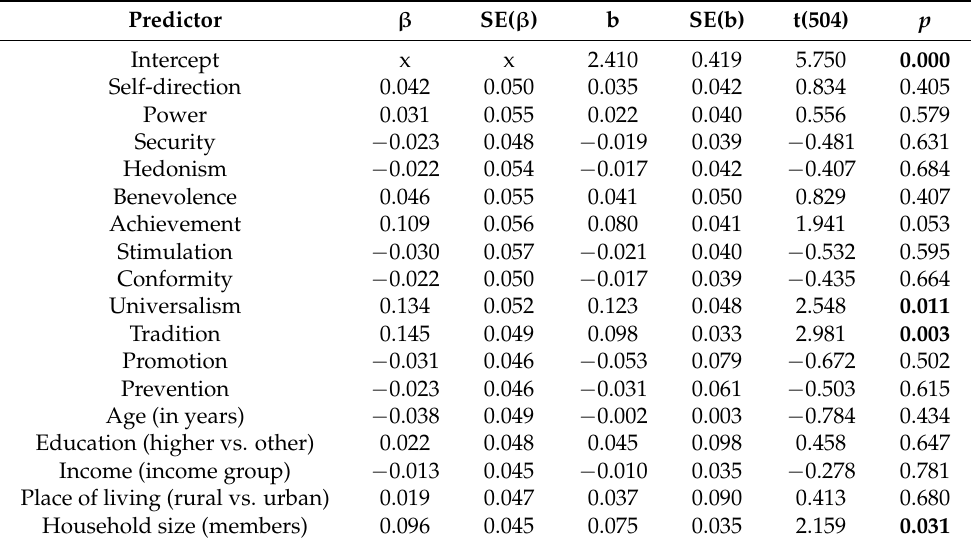
Table 12. The impact of the Schwartz values and regulatory focus on the WTP a price premium for domestic food products among women with control